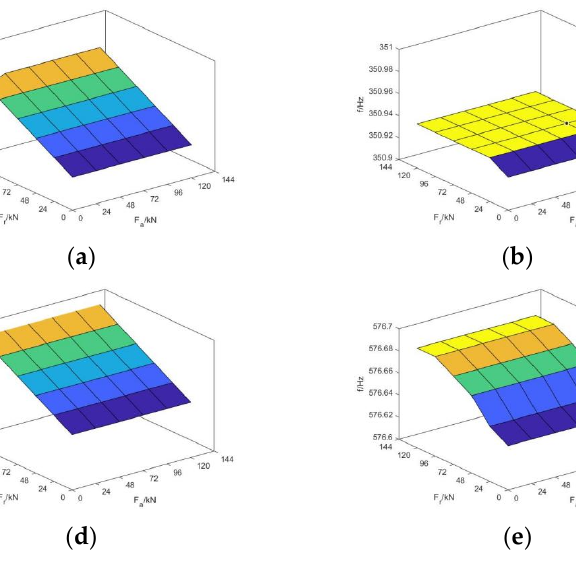
Figure 12. Variation of the first six-order natural frequencies of the bearing load of the turntable; ( a ) Variation of first-order frequency; ( b ) Variation of second-order frequency; ( c ) Variation of third- order frequency; ( d ) Variation of fourth-order frequency; ( e ) Variation of fifth-order frequency; ( f ) Variation of sixth-order frequency.